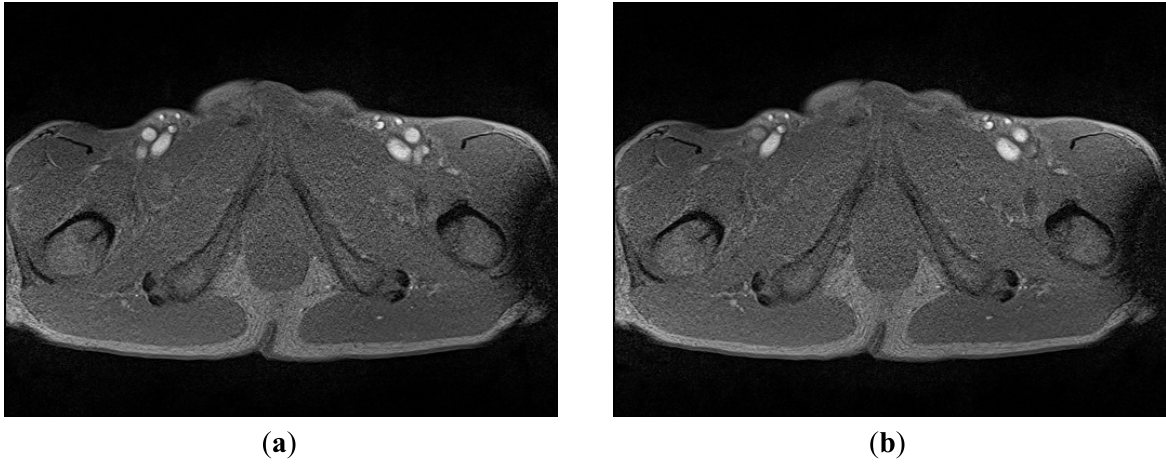
Figure 3. Two raw MRA images in one sequence. Each sequence contains 50 images. ( a ) Image taken in the systolic phase; ( b ) Image taken in the diastolic phase. The arrow indicates where the SFA